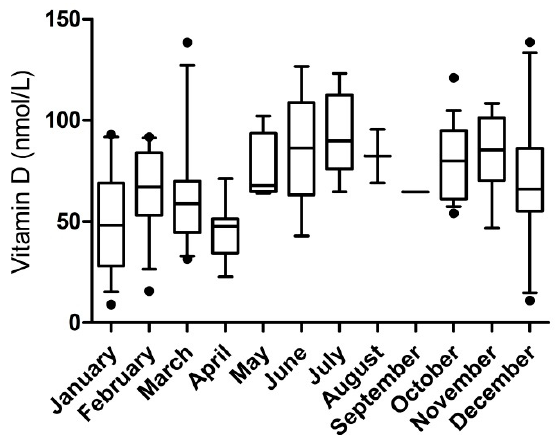
Figure 2. Vitamin D concentrations per month. Whiskers indicating 10–90 percentiles.